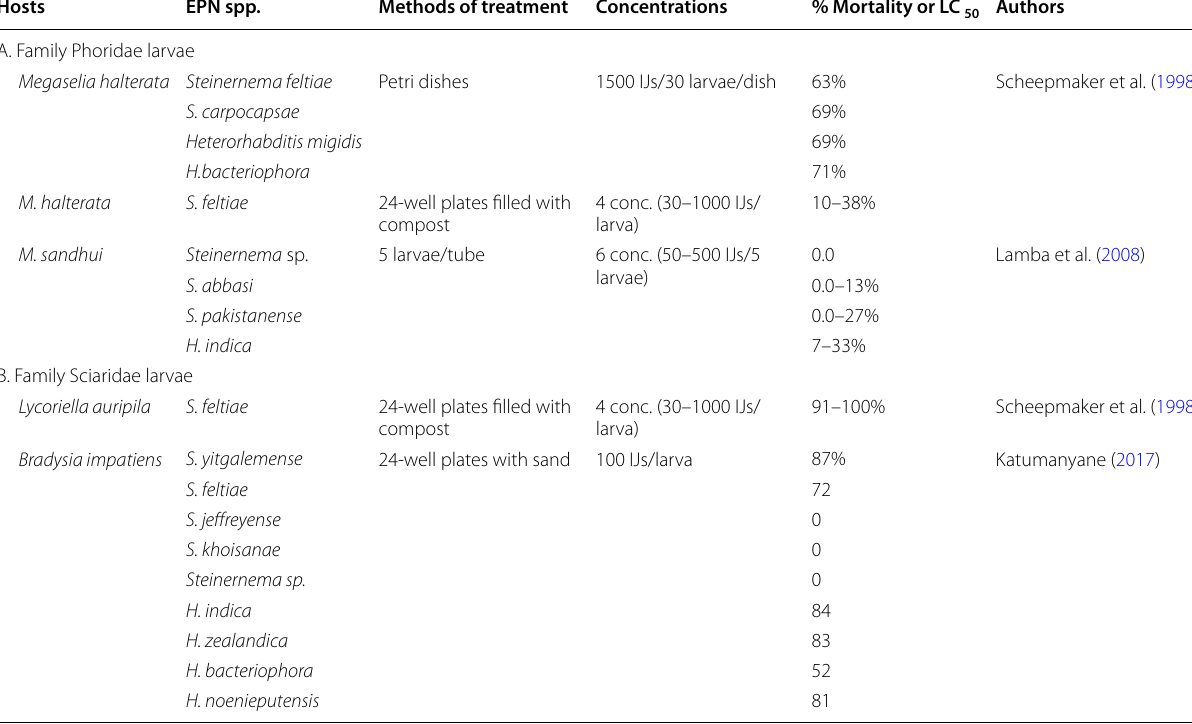
Table 3 Efficiency of entomopathogenic nematodes against mushroom flies Hosts EPN